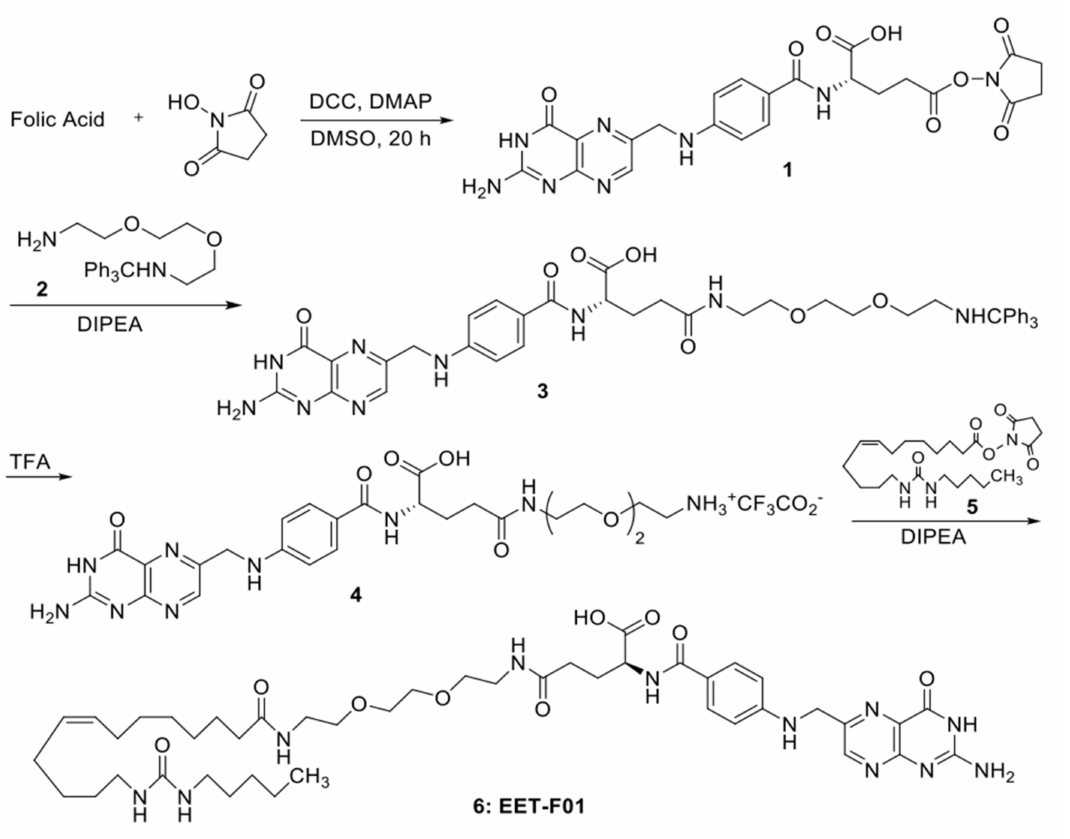
Figure 7. Synthesis of